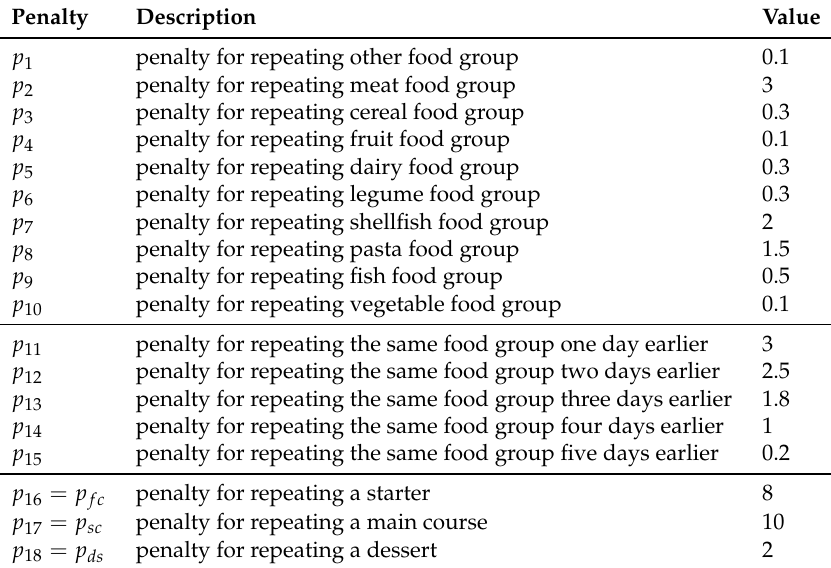
Table 1. Types of penalties defined to calculate the level of repetition objective.